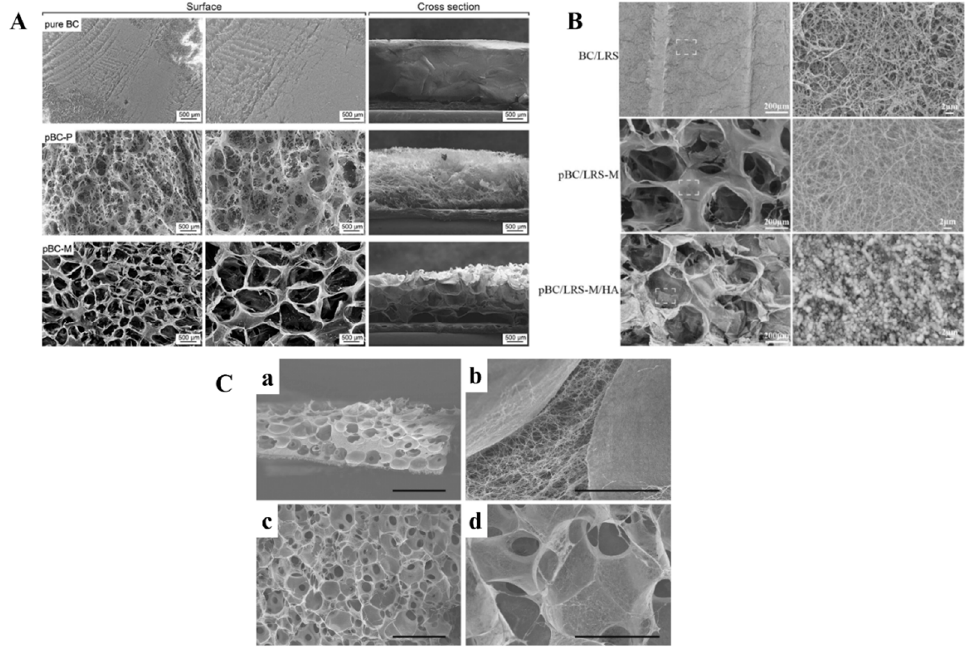
Figure 2. SEM images of ( A ) pure BC, pBC-P, and pBC-M, ( B ) BC–LRS, pBC–LRS-M and pBC–LRS- M–HA scaffolds; ( C ) ( a ) cross-section images of porous BC tube, ( b ) close up view of BC wall between pores, ( c ) porous structure of outer side, and ( d ) higher-resolution image of small area on the outer side of BC scaffold. Reprinted with permission [61–63]. Copyright 2015 Elsevier, 2019 Springer Nature, and 2010 John Wiley and Sons.